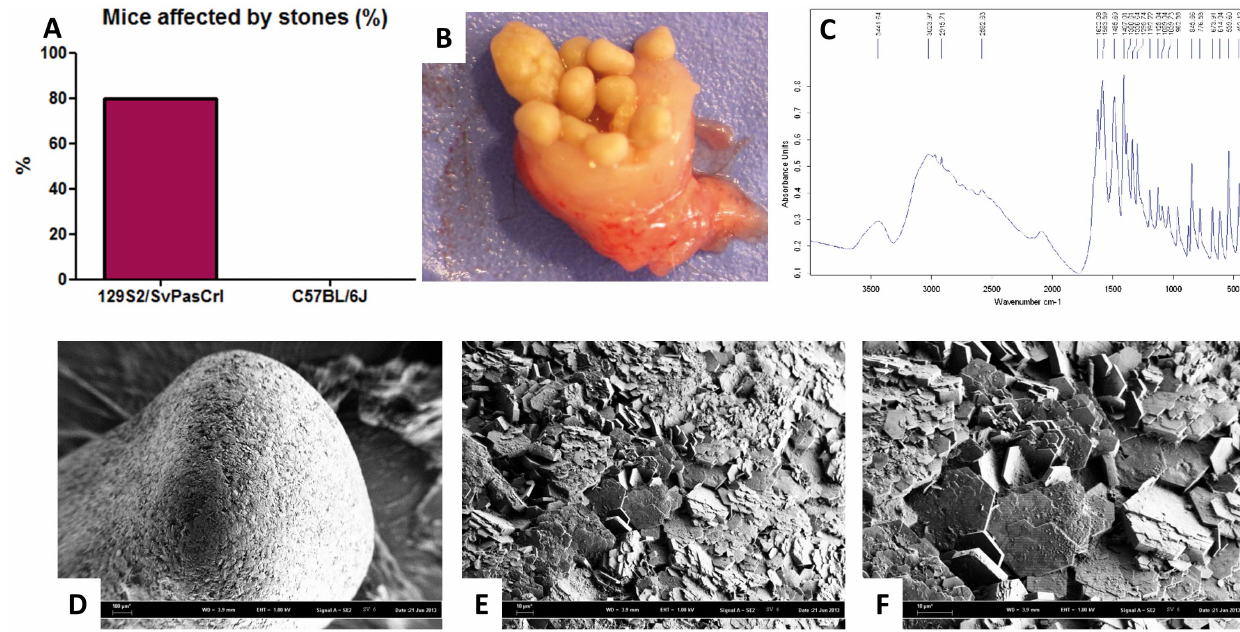
Figure 1. 129S2/SvPasCrl mouse is affected by cystine urolithiasis. A , Eighty percent of 129S2/SvPasCrl mice sacrificed at 16 weeks or dead before 16 weeks have been affected by urolithiasis whereas no C57BL/6J mice has been affected, p=0.0007, n=10/group. B , Bladder stones in a 129S2/SvPasCrl mouse. C , Spectrum of cystine was obtained by FTIR analysis of mouse stones. D–F , Scanning electron microscopy of a stone, at x58, x506, and x1070 magnification respectively, revealed the typical flat hexagonal structure of cystine crystals.